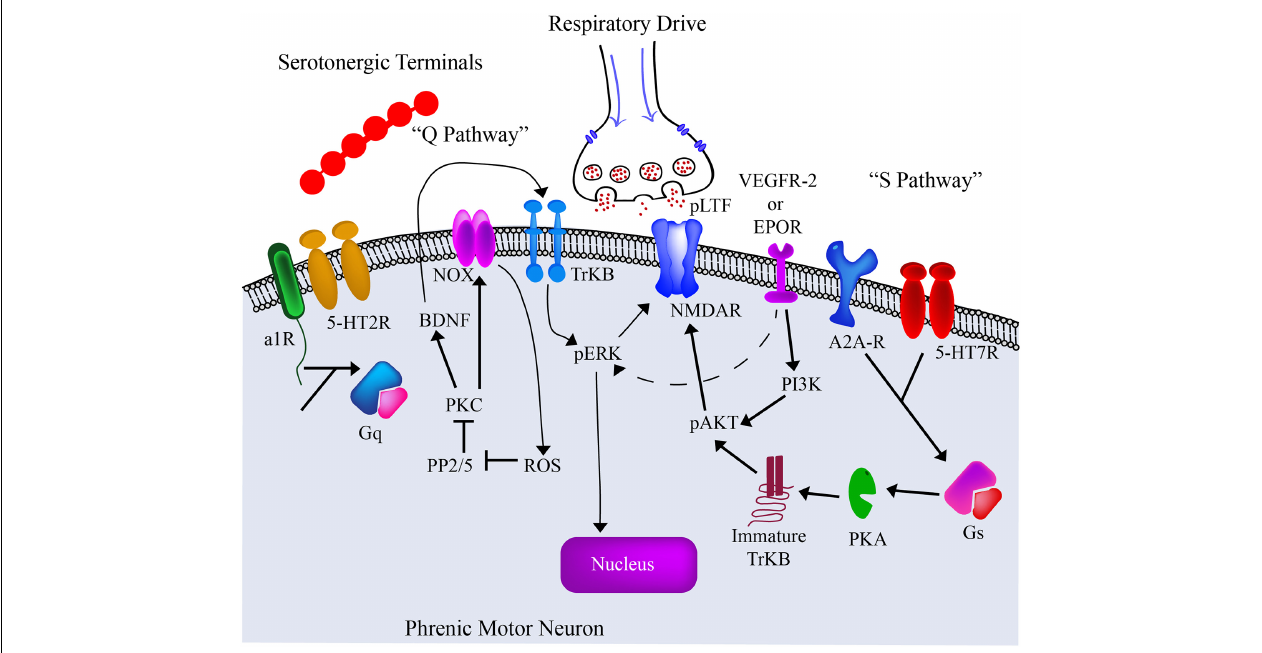
FIGURE 4 | The current model of the “Q” and “S” Pathways. The past several decades has seen significant advances in our understanding of intermittent hypoxia and its effects on the spinal phrenic network. Particular focus has been given to changes on the phrenic motoneuron itself. From these ongoing studies we are gaining an appreciation of the cellular receptors and intracellular pathways that contribute to plasticity and altered motor function under different respiratory conditions. The current pre-clinical and clinical goal is to employ therapeutic strategies that can harness these mechanisms and enhance motor output after spinal cord injury or disease. Adapted from Dale-Nagle et al. (2010b); Gonzalez-Rothi et al.